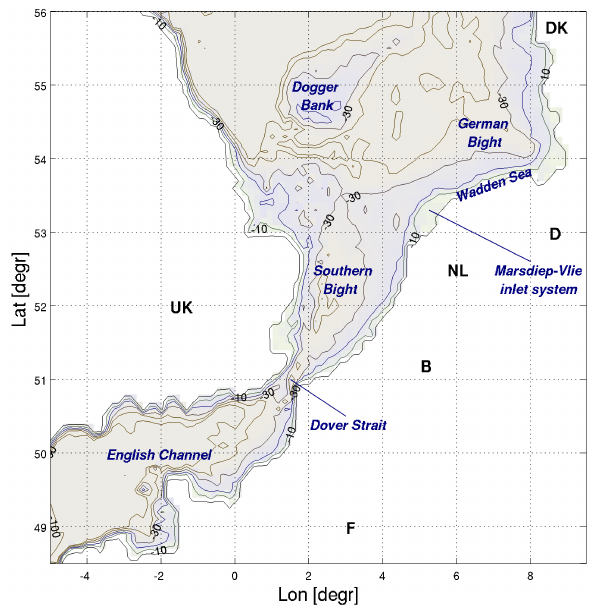
Figure 1. Topography of the research area, along with area and lo- cation names. Note that the area shown does not correspond with the entire domain of the hydrodynamic simulations, which spans 48.2–60.1 ◦ N, − 7–16.9 ◦ E, and includes part of the Baltic